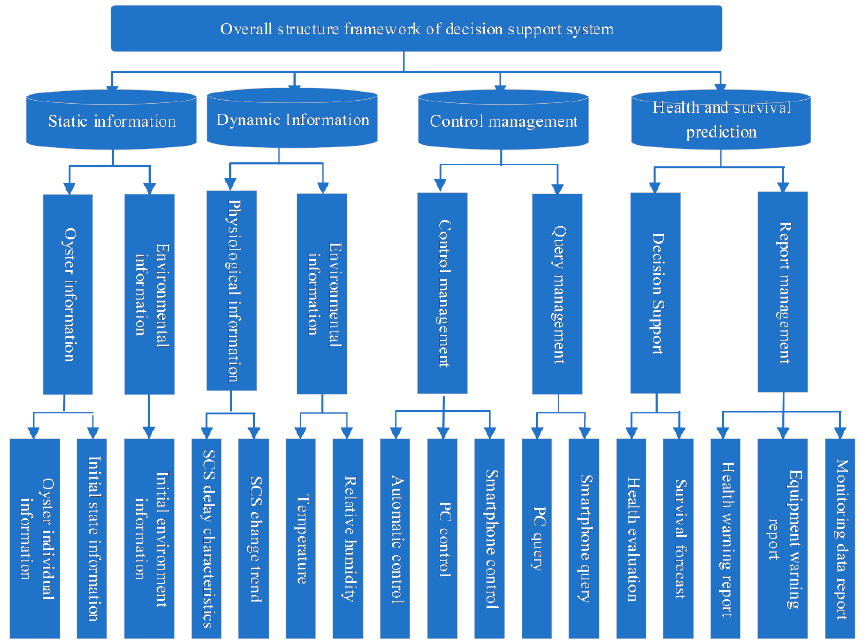
Figure 4. Schematic diagram of the overall architecture of the support system.